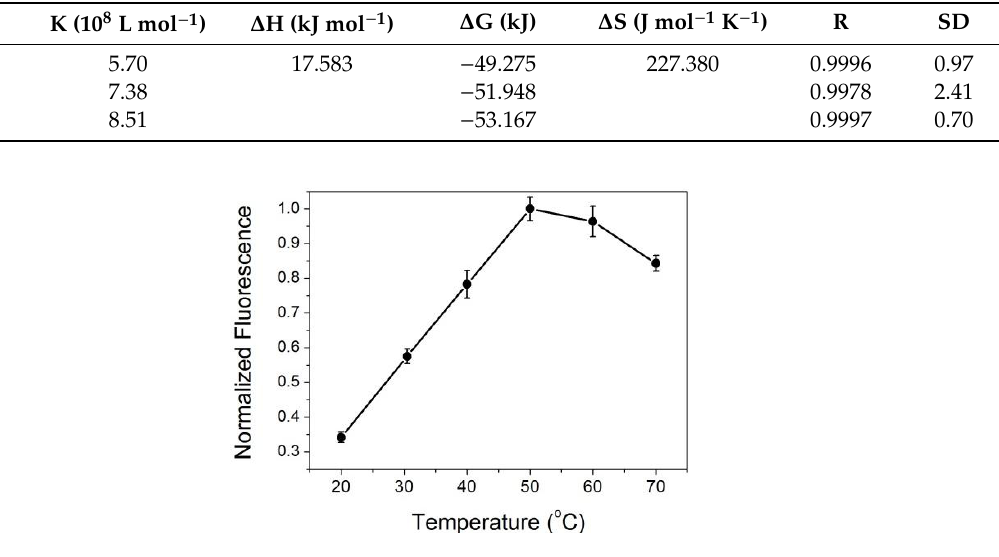
Figure 2. ( A ) Photoemission spectra of BSA (7.5 × 10 ‒7 M, 50 μg/mL) with different concentrations of ATT-AuNCs (range from 0 to 100 nM) upon excitation at 280 nm at pH 5.0, 33 °C. ( B ) Stern–Volmer plot for fluorescence quenching of BSA by ATT-AuNCs. Error bars represent the standard deviations across three repetitive experiments. Table 1. Calculated thermodynamic parameters for ATT-AuNCs-BSA composite.